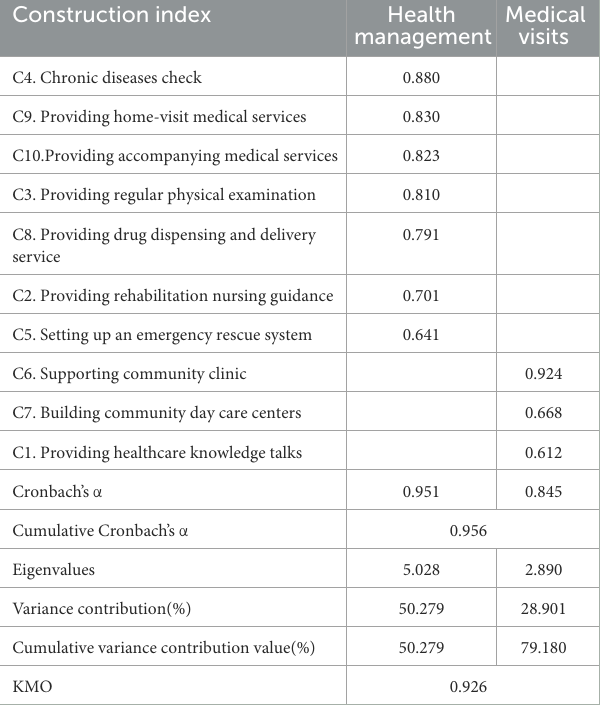
TABLE 6 Investigator’s structural variables analysis